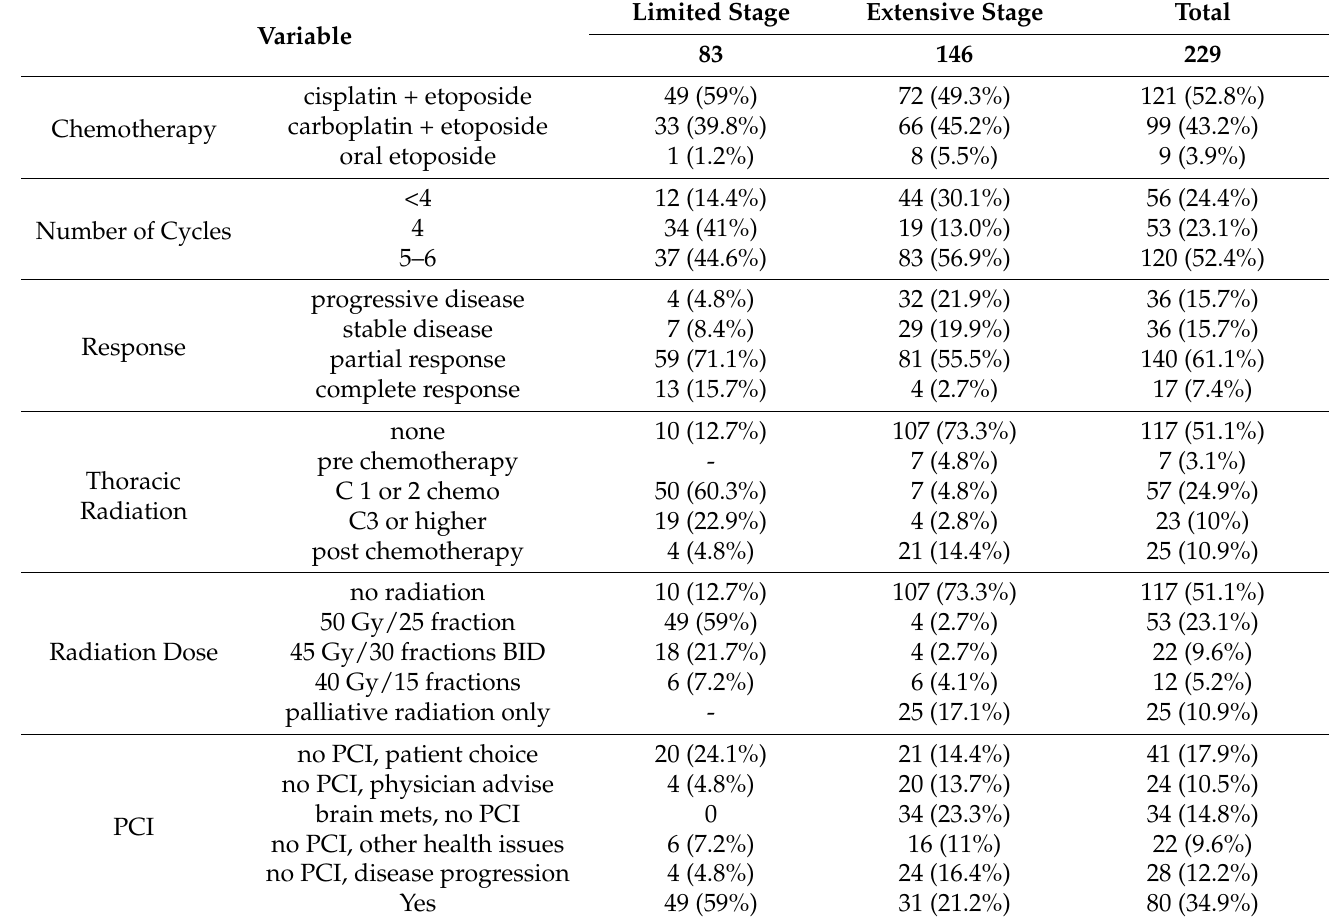
Table 2. Summary of treatments